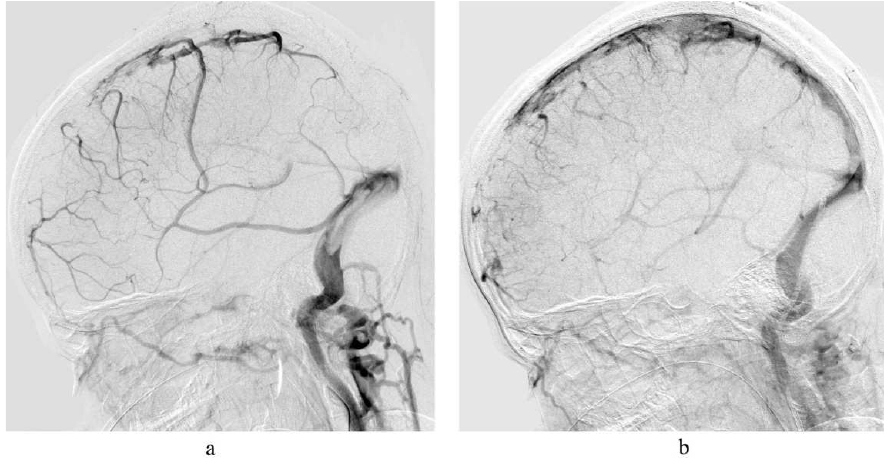
Figure 2. A child with a history of acute lymphocytic leukemia (ALL) presented with altered mental status. ( a ) Preprocedure lateral left internal carotid artery angiogram demonstrates thrombosis of superior sagittal sinus and left transvers sinus; ( b ) Postprocedure lateral left internal carotid artery angiogram after treatment with Solitaire Revascularization Device demonstrate patency of the superior sagittal sinus and left transverse sinus with satisfactory flow (Q = 0.57). Transfemoral venous access is established to perform MT under general anesthesia either with a 6 F/7F long sheath or a guiding catheter placed distally in the internal jug- ular vein/jugular bulb or sigmoid. A microcatheter was navigated over a microwire into the occluded venous compartment (all sinuses are accessible). The MT methods include: direct aspiration (with a VacLok syringe), stent retriever thrombectomy (retrieving the clot with a 6 × 30 mm Solitaire or Catch Maxi stent), balloon-assisted MT and venoplasty or a combination of these methods.